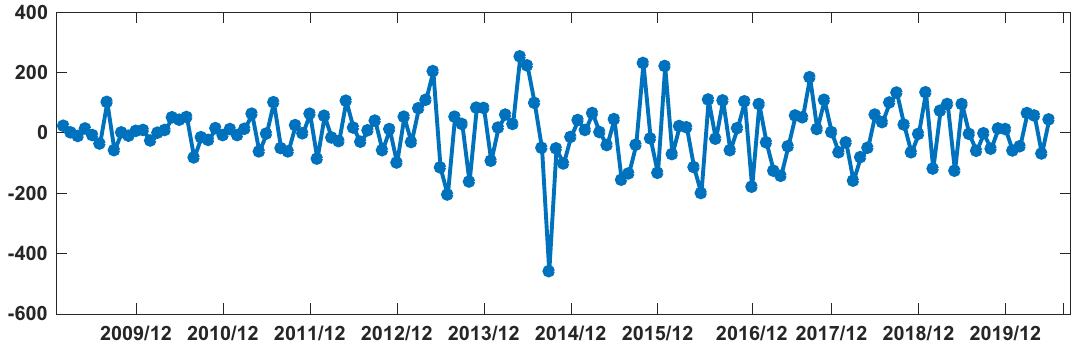
Figure 3. Plot of time series after differencing.